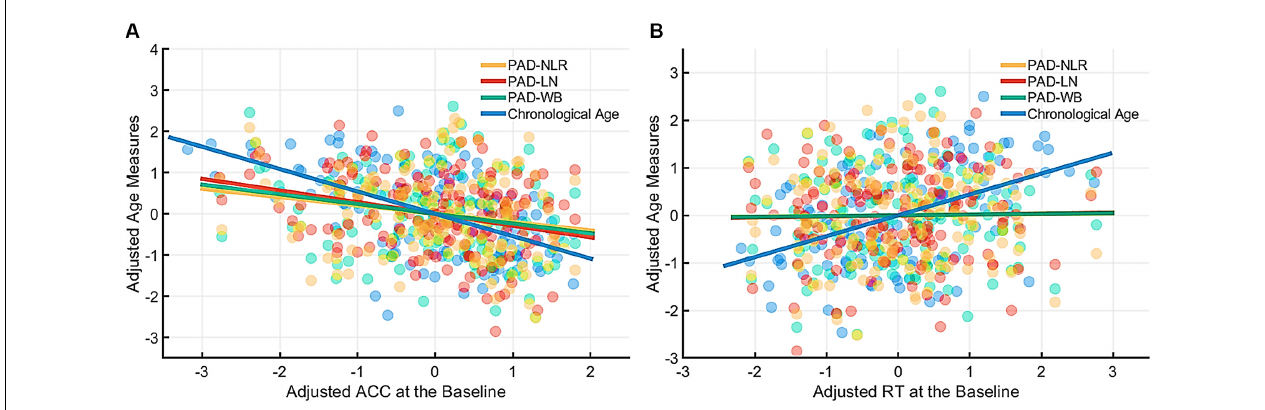
FIGURE 3 | Partial correlation of cognitive indices (ACC and RT) at the baseline condition with age measures (chronological age and brain age). The brain age measures were significantly correlated with ACC under the baseline condition (A) but not with RT. (B) The lines of PAD (NLR, LN, and WB) were almost overlapped. Abbreviation: ACC, accuracy; RT, response time; PAD, predicted age difference; NLR, non-language regions; LN, language network; WB, whole